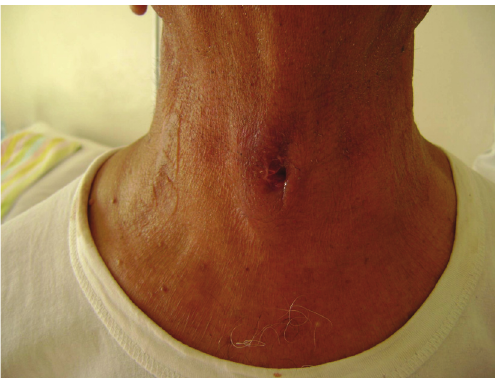
Figure 1: Sinus opening with moderately swollen and hyperemic skin around it.